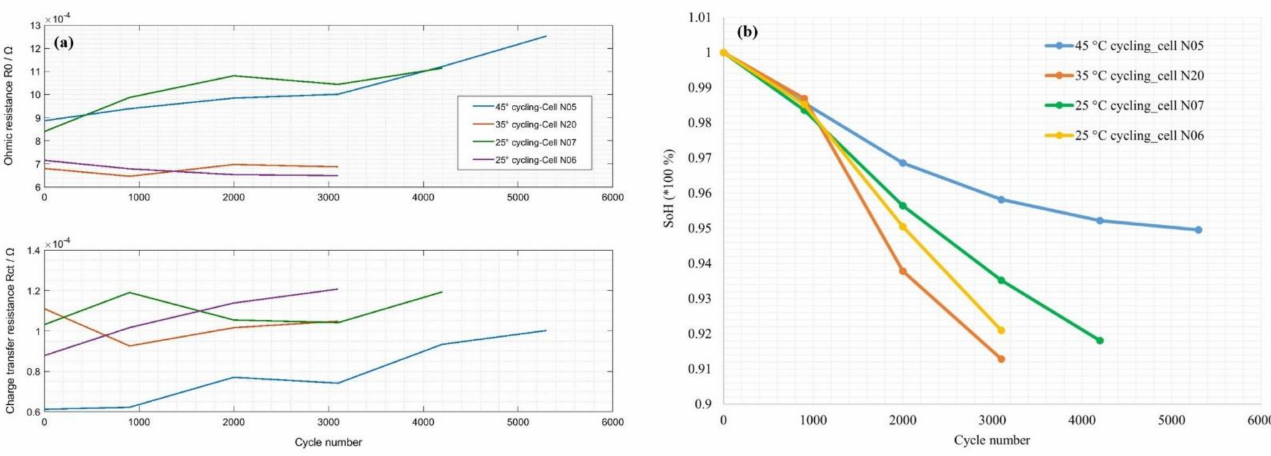
Figure 5. Cell degradation cycled at different DoD and middle SoC; ( a ) impedance evolution, ( b ) capacity fade.